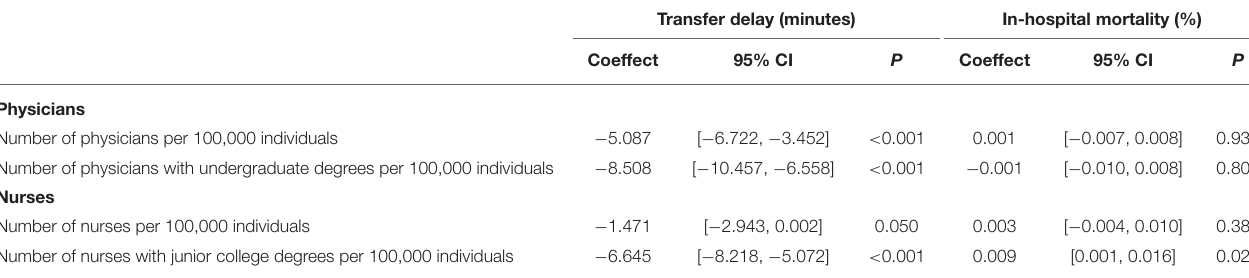
TABLE 4 | Associations between district-level healthcare professionals and patient-level transfer delay and in-hospital